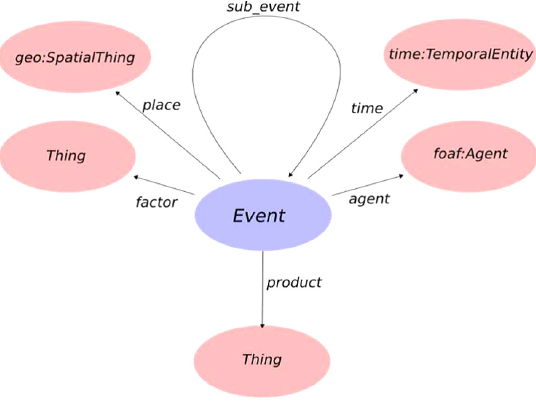
Fig. 1. The event model. This ontology deals with the notion of cognitive agents classifying arbitrary time/space